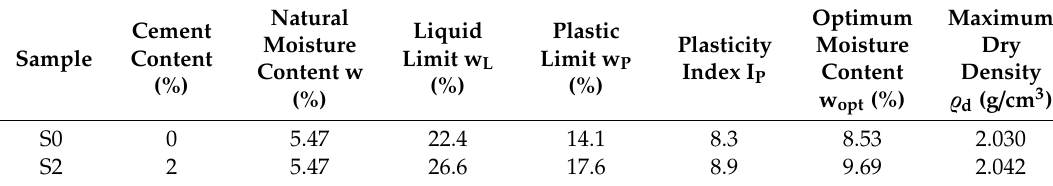
Table 2. The basic physical properties of silty soil. S0, sample with 0% cement